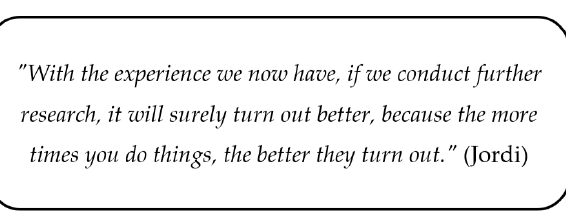
Figure 7. Co-researcher’s opinion 12.